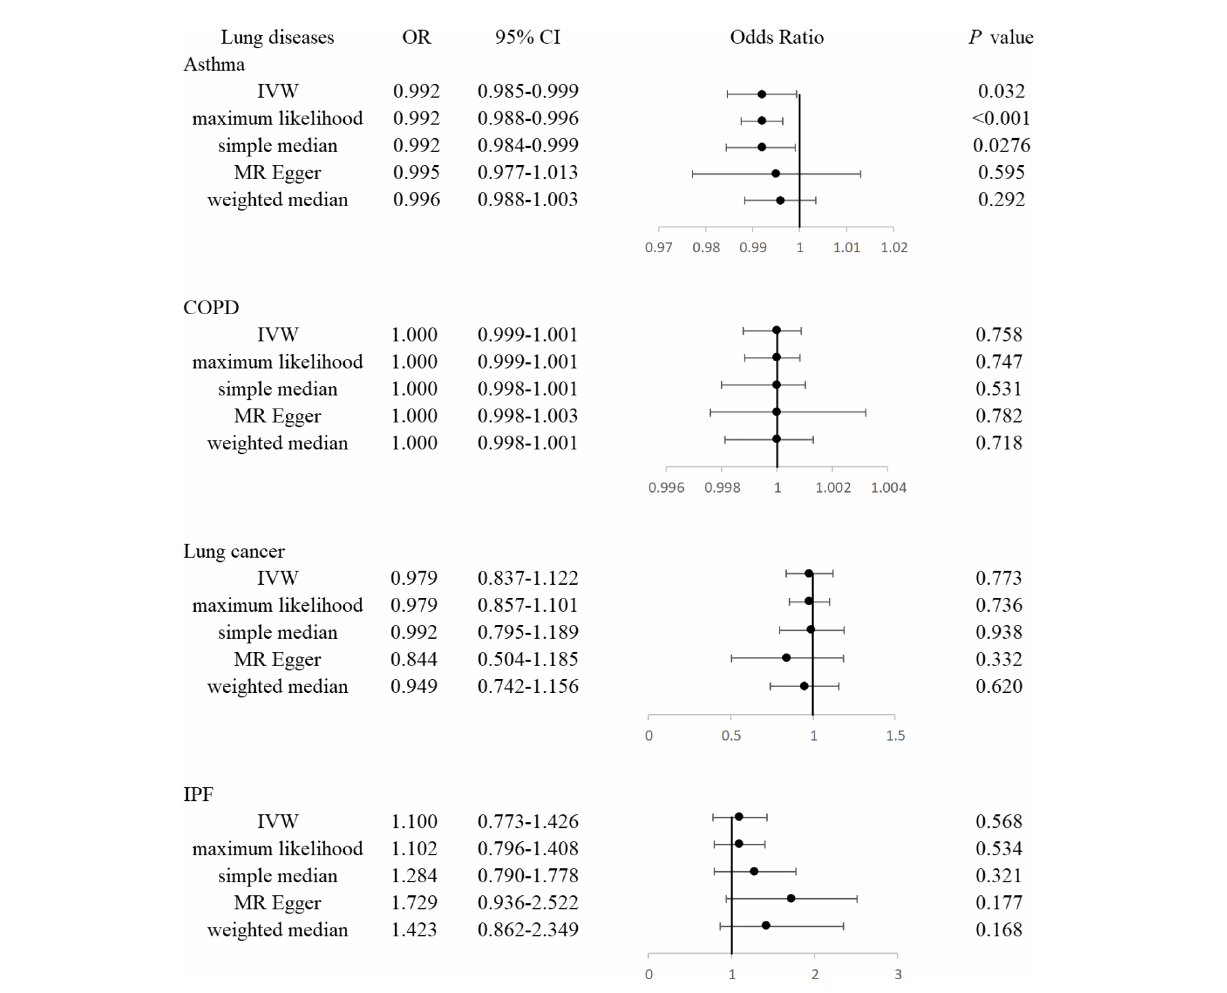
FIGURE 2 The forest plot showed associations of genetically predicted circulating IGF-1 with asthma, COPD, lung cancers, and IPF,